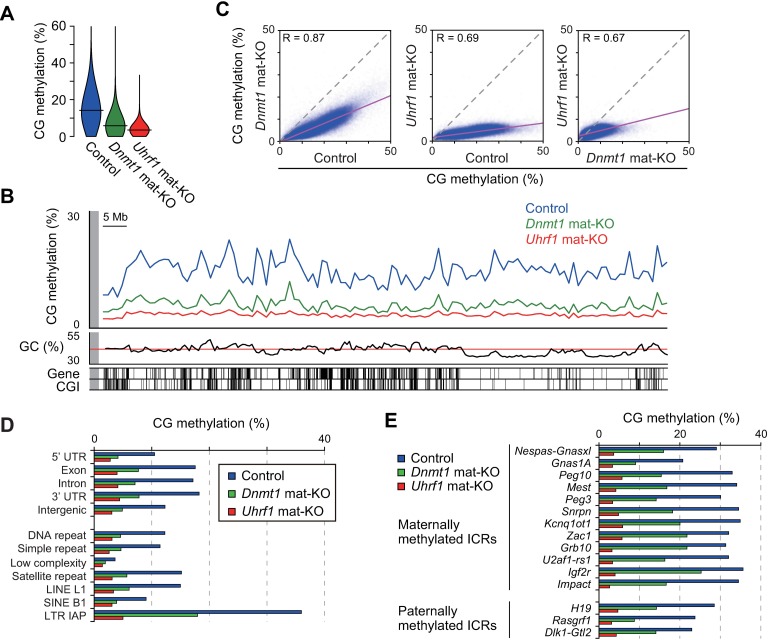
The role of maternal UHRF1 in CG maintenance methylation in preimplantation embryos.(A) Violin plots showing the distribution of the 10-kb genomic regions with different CG methylation levels in control [Uhrf12lox/+], Uhrf1 mat-KO, and Dnmt1 mat-KO blastocysts. The horizontal bars indicate the mean CG methylation levels. (B) The genomic distribution of CG methylation across chromosome 14 in control and mat-KO blastocysts. The CG methylation levels of 1-Mb windows are shown. GC contents, RefSeq genes, and CGIs are shown at the bottom. (C) The correlations between the CG methylation levels of the 10-kb genomic windows in the control and mat-KO blastocysts. (D) The CG methylation levels of respective portions of the genic regions, intergenic regions, and various repetitive sequences in control and mat-KO blastocysts. (E) The CG methylation levels of the ICRs in control and mat-KO blastocysts.